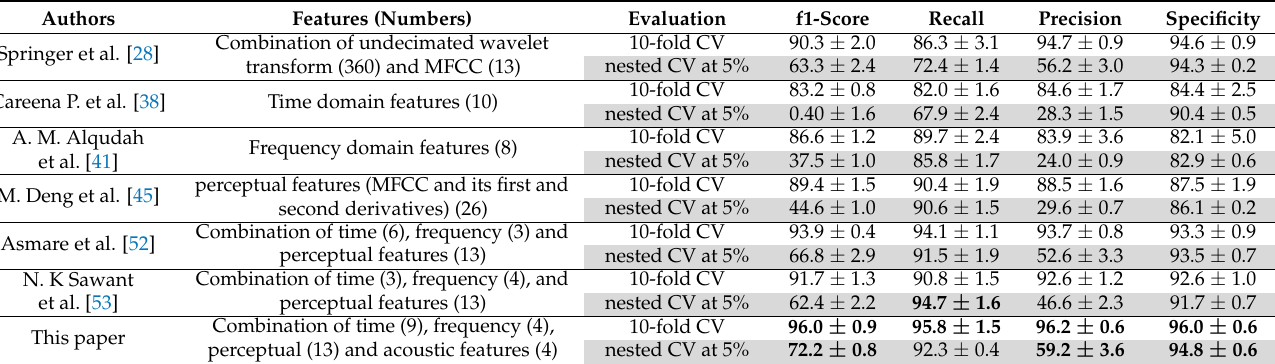
Table 4. Results (mean ± standard deviation %) of stratified nested 10-fold cross-validation and imbalanced nested cross-validation at 5% RHD prevalence rate using six sets of state-of-the-art features when evaluated on our RHD